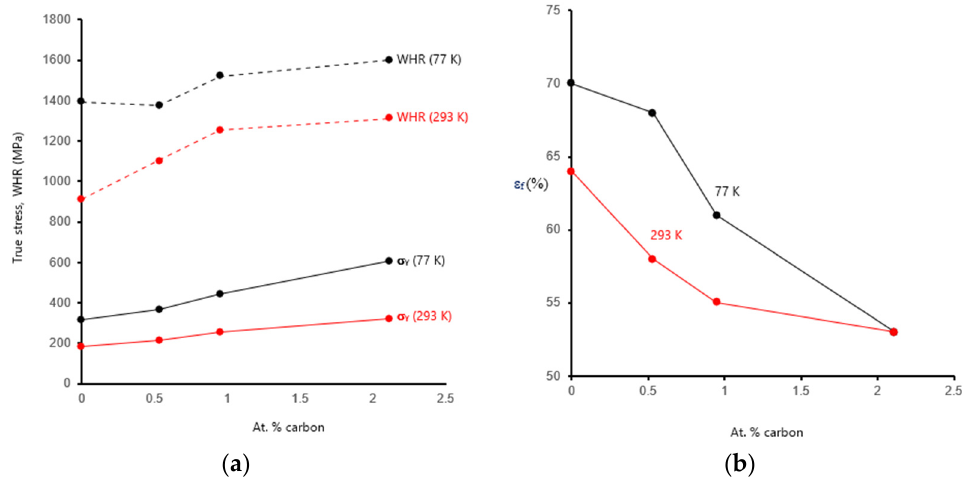
Figure 4. ( a ) Yield stress ( σ y ) and work-hardening rate (WHR) for CoCr 0.25 FeMnNi at 77 K and 293 K. ( b ) Elongation to failure ( ε f ) for CoCr 0.25 FeMnNi at 77 K and 293 K. Data from Klimova et al. [38].